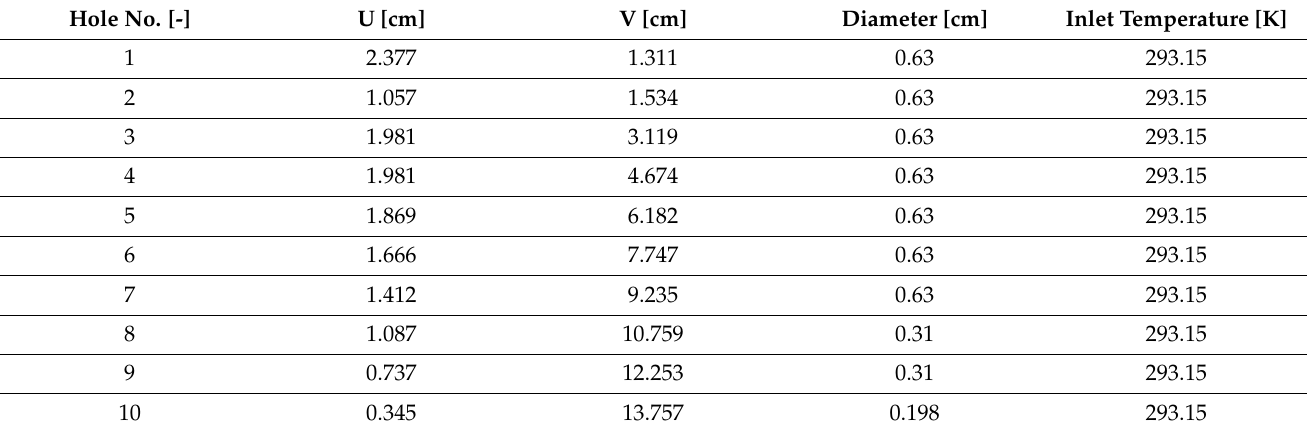
Table 1. C3X cooling holes’ position, diameters and assumed inlet coolant temperature.